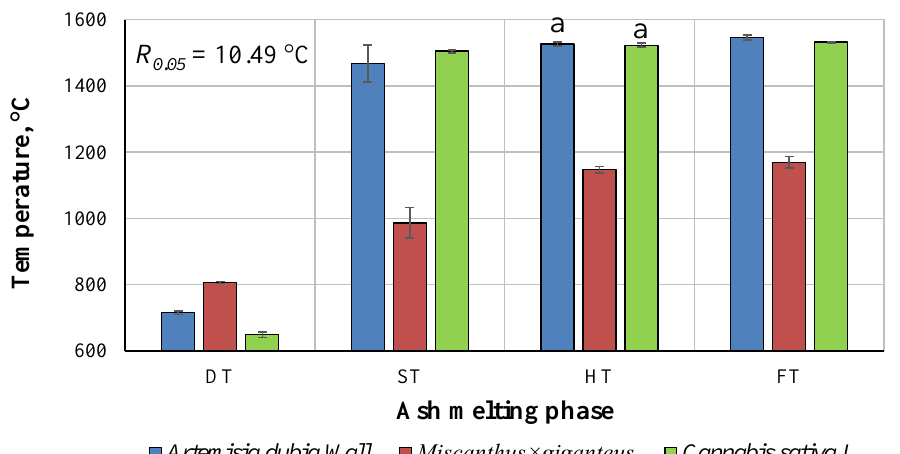
Figure 5. Ash melting temperature of Artemisia dubia Wall., Miscanthus × giganteus and Cannabis sativa L. not fertilized: DT, deformation temperature; ST, softening temperature; HT, hemispherical temperature; FT, flow temperature; a, there are no statistically significant differences (p < 0.05) between the columns marked with the same letter, as assessed using the least significant difference.